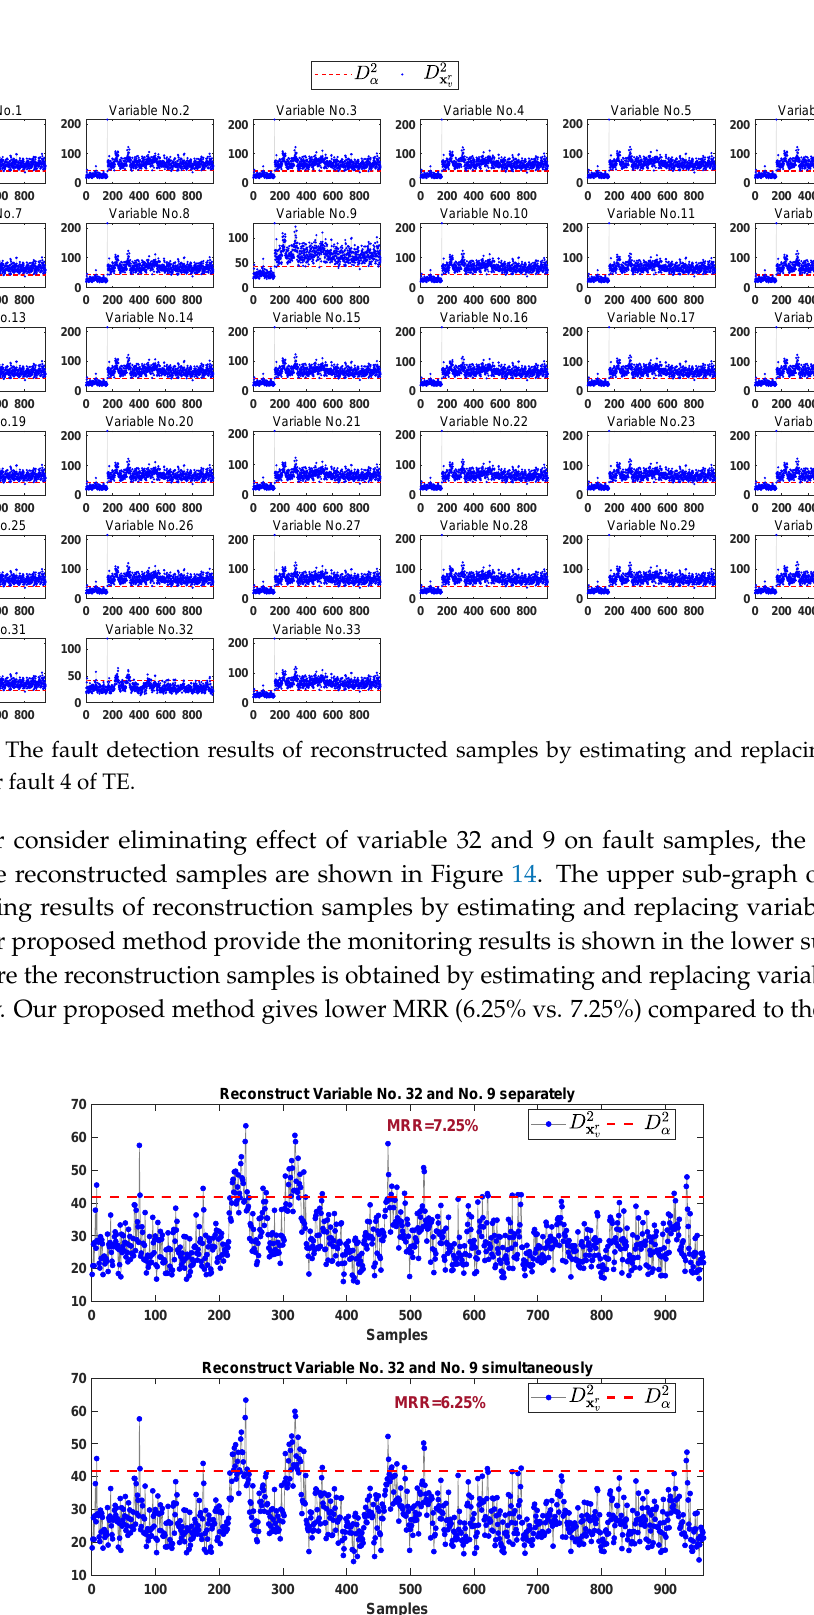
Figure 14. The fault detection results of reconstructed samples by estimating and replacing variable No.32 and No.9 for fault 4 of